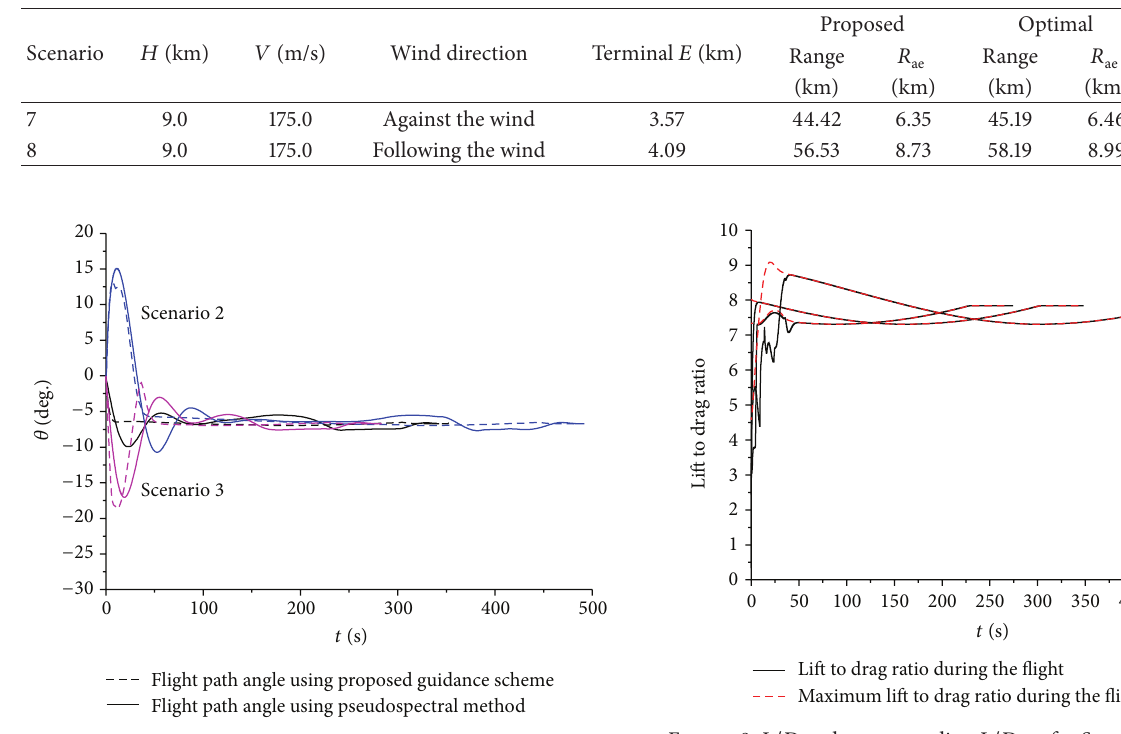
Figure 8: 𝐿/𝐷 and corresponding 𝐿/𝐷 max for Scenarios 1, 3, and 6.